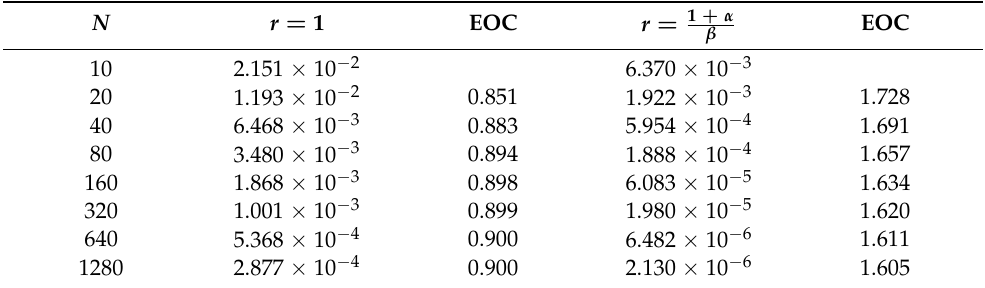
Table 3. Table showing the maximum absolute error and EOC for solving (25) using the predictor- corrector scheme for α = 0.6, β = 0.9.